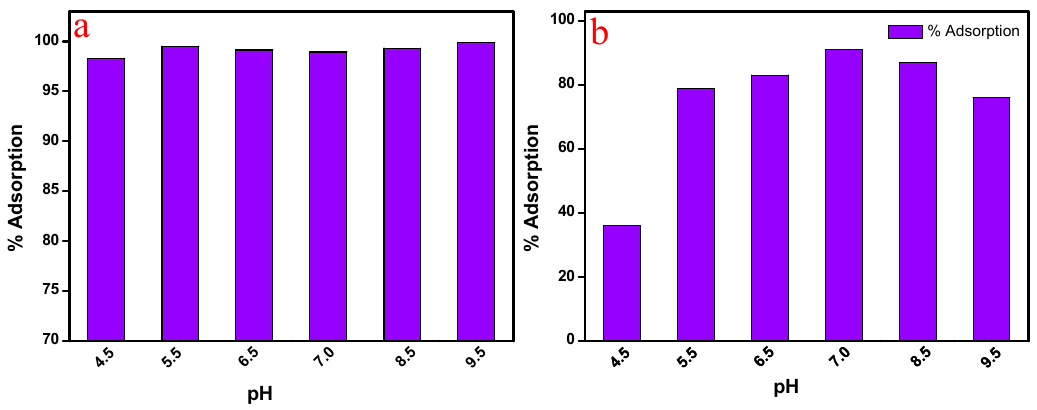
Figure 9. Effect of pH on percentage removal of ( a ) MB and ( b ) MO in the presence of GOPSr-2 (initial MB and MO concentration: 20 mg·L − 1 ; amount of adsorbent (MB): 0.5mg·mL − 1 , (MO): 2 mg·mL − 1 ; time: 30 min at room temperature).